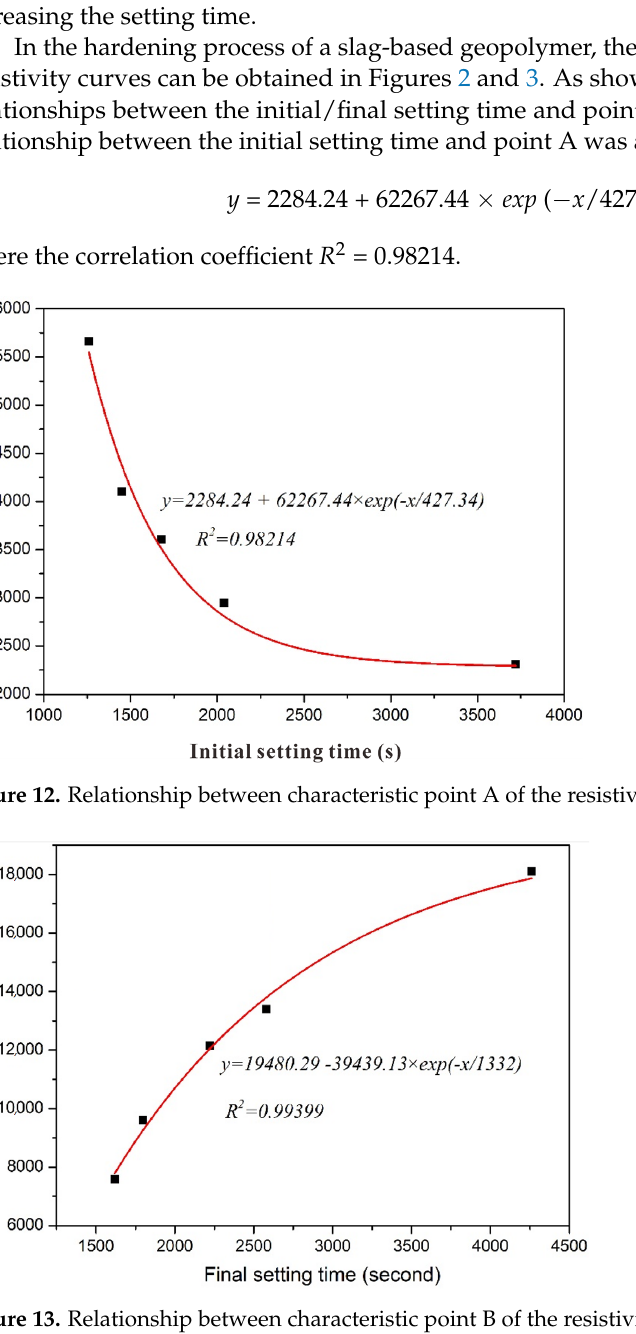
Figure 13. Relationship between characteristic point B of the resistivity and final setting time.